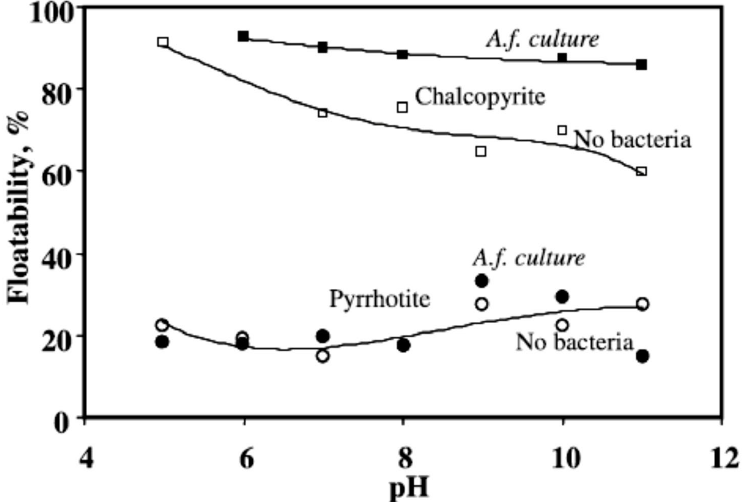
Figure 5. Floatability of chalcopyrite and pyrrhotite in the presence of a collector with (solid sym- bols) and without bio-modification (open symbols). Adapted from Pecina-Treviño et al.